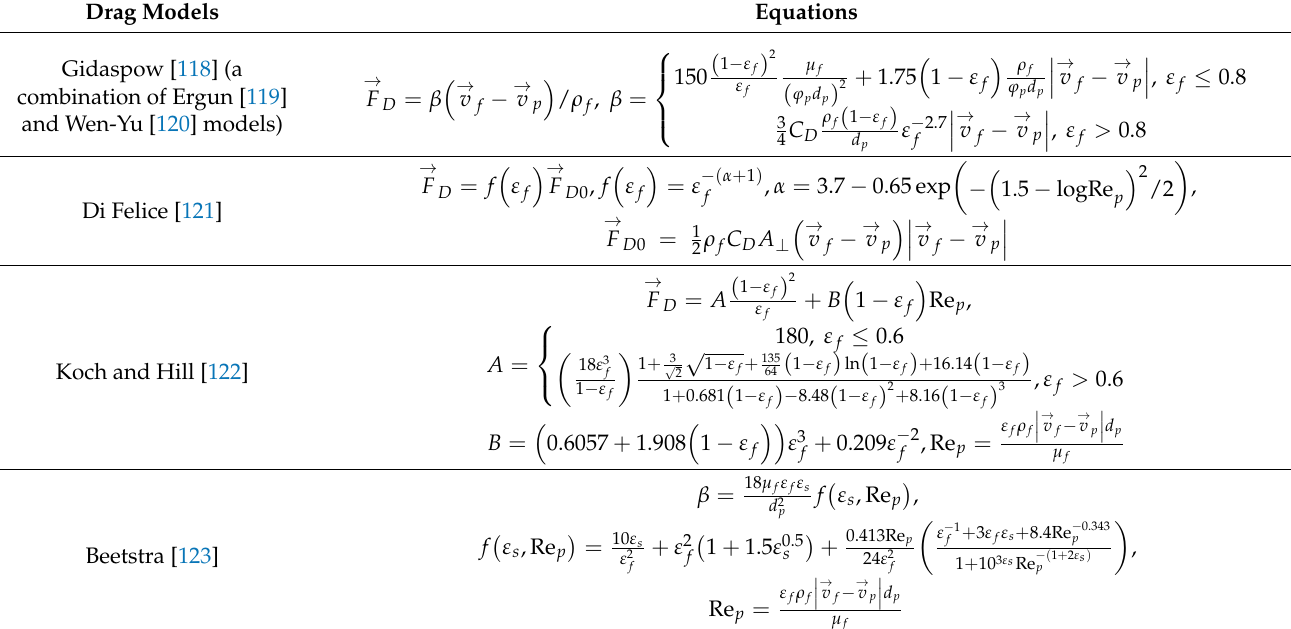
Table 1. Drag models for spherical